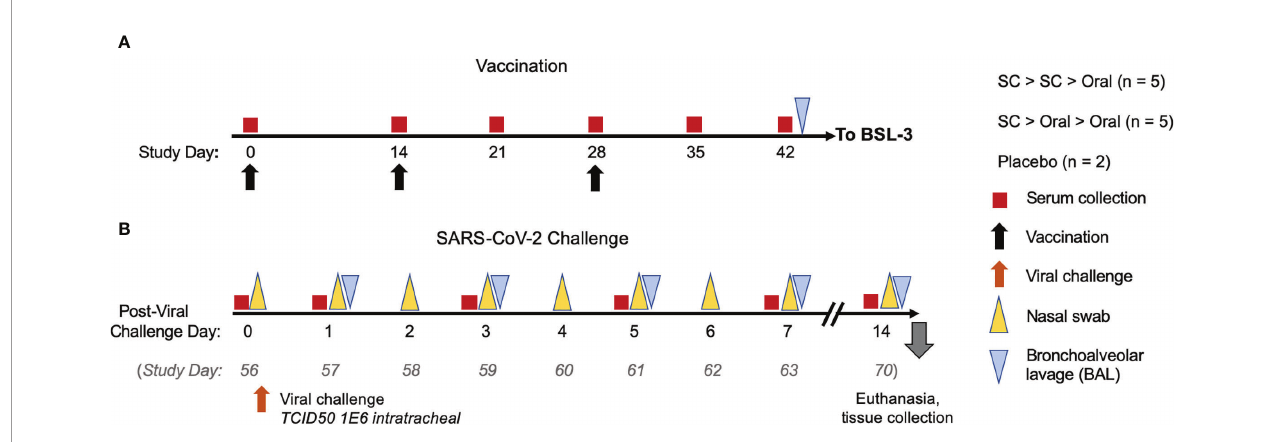
FIGURE 2 | NHP study design . (A) NHP were vaccinated either by subcutaneous (SC) injection of 1 x 10 11 VP hAd5 S-Fusion + N-ETSD on Study Days 0 and 14, with an oral boost of 1 x 10 10 IU on Study Day 28 (n = 5) or received one SC prime injection and two oral boosts (n = 5). Control NHP received placebo by an SC > SC > Oral regimen (n = 2). Sera were collected as indicated (red boxes) throughout the study. (B) On Study Day 42, NHP were transferred to a BSL-3 facility for viral challenge (orange arrow) on Study Day 56 (described as Challenge Day 0 for post-challenge analyses here) with 1x10 6 TCID 50 VP of SARS-CoV-2 intranasally and intratracheally. Nasal samples (yellow triangles) and bronchoalveolar lavage (BAL) samples (gray triangles) were collected as indicated. Animals were euthanized 14 days after challenge and tissues collected for